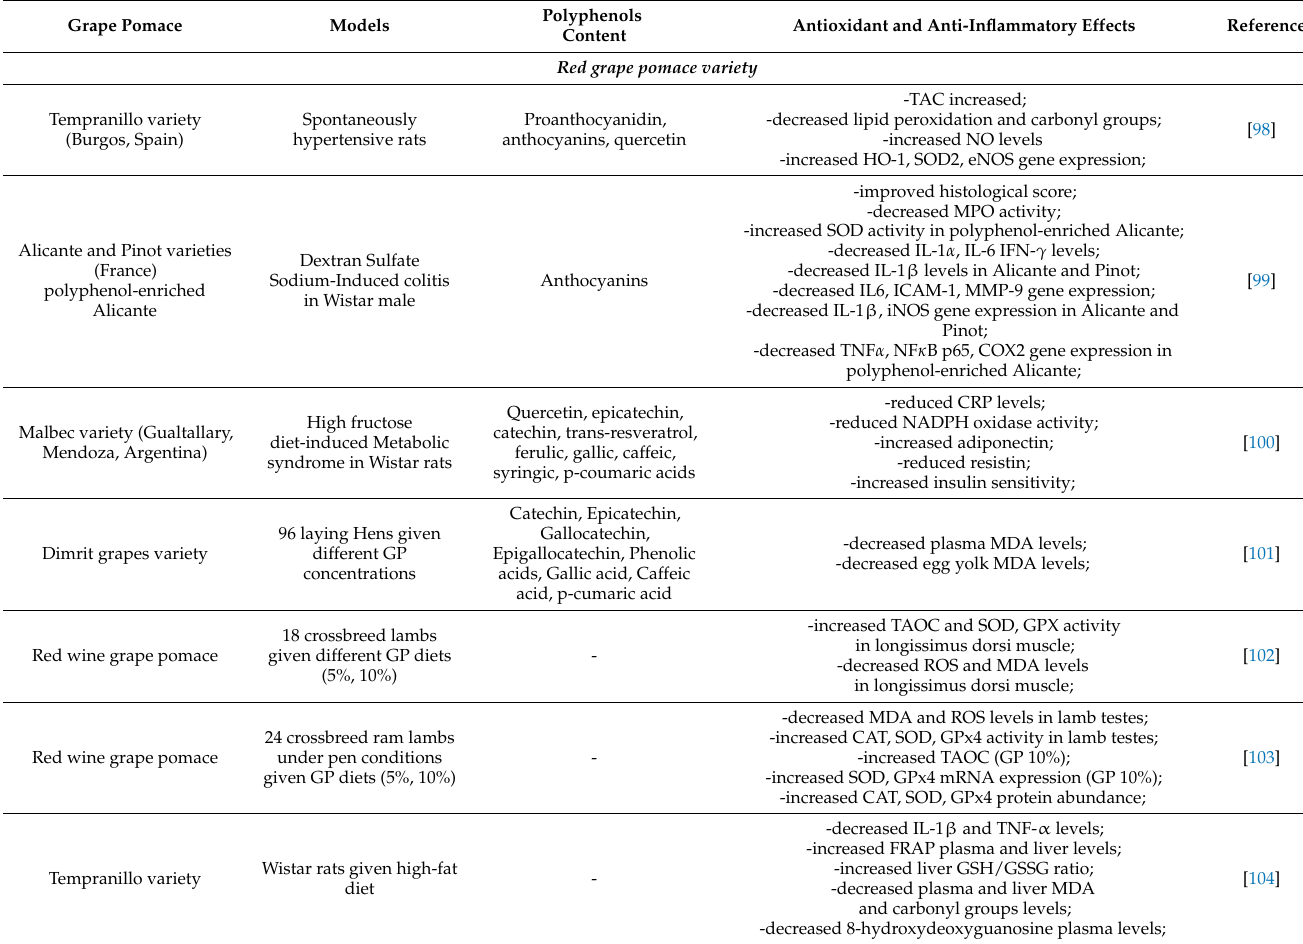
Table 2. In vivo beneficial actions of grape pomace in oxidative stress and